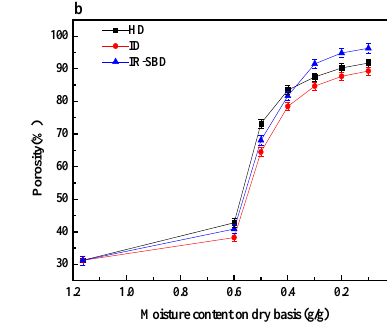
Figure 7. Changes in porosity of peanut kernel ( a ) and peanut shell ( b ) during three drying methods.